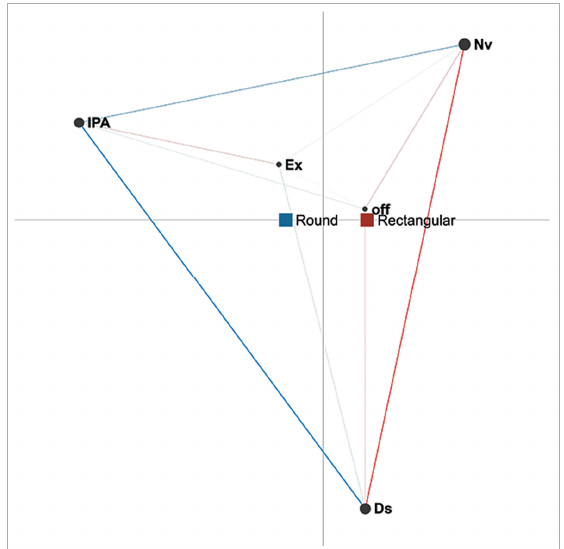
Figure 6. Difference network for male students under two conditions (round and rectangular